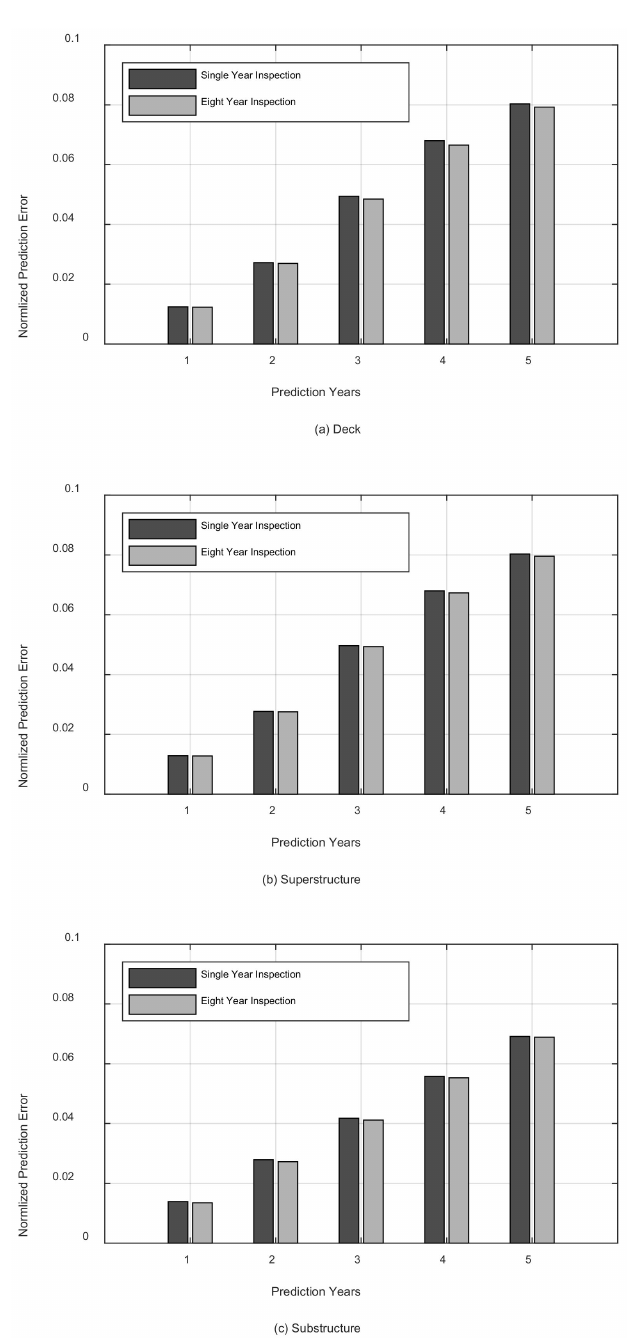
Figure 6. Normalized prediction error comparison for ( a ) deck, ( b ) superstructure, and ( c ) substructure elements when explanatory variables were determined by using single- and eight-year inspection